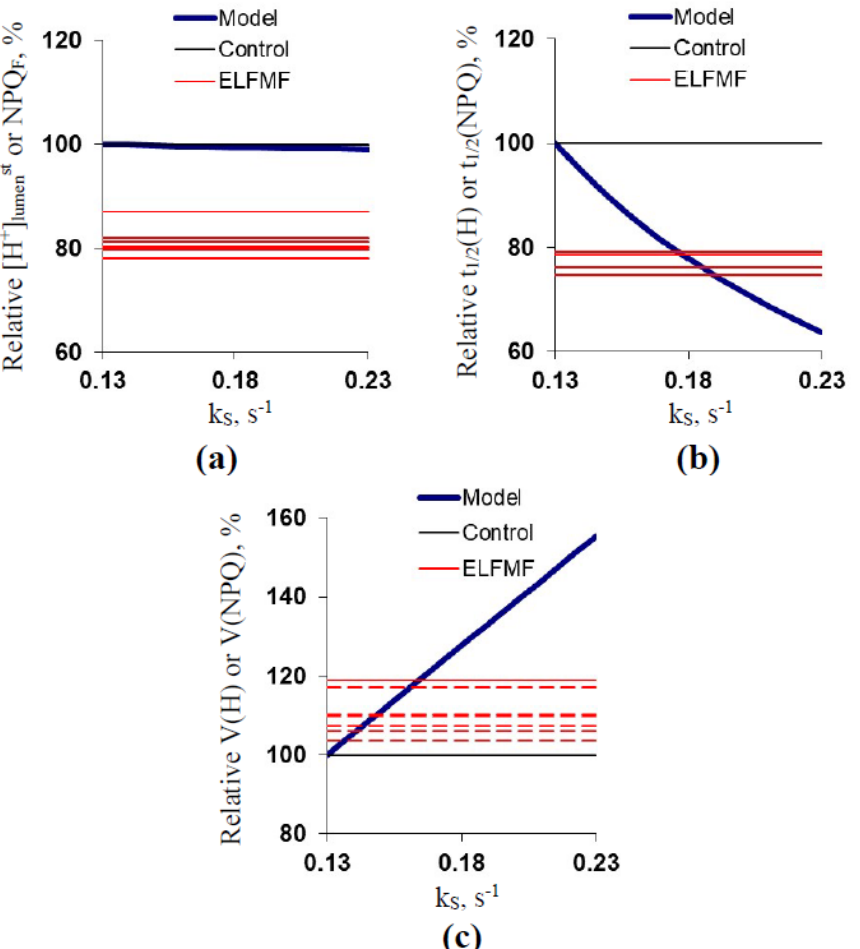
Figure 7. Dependencies of simulated [H + ] lumenst ( a ), t 1/2 (H) ( b ), and V(H) ( c ) on k S . Relative values were calculated as percentage from simulated values at k ETC = 0.05 s − 1 , k S = 0.13 s − 1 , and k L = 0 s − 1 (see Figure 5b). Figure 7 also shows relative control and experimental averaged values of NPQ F ( a ), t 1/2 (NPQ) ( b ), and V(NPQ) ( c ); the experimental values include all variants of ELFMF treatments (with different ELFMF intensities). The results from Figures 2 and 3 were used. Relative values were calculated as a percentage from control values; standard errors were not included in Figure 7. Dotted lines show experimental parameters, which did not significantly differ from the control.